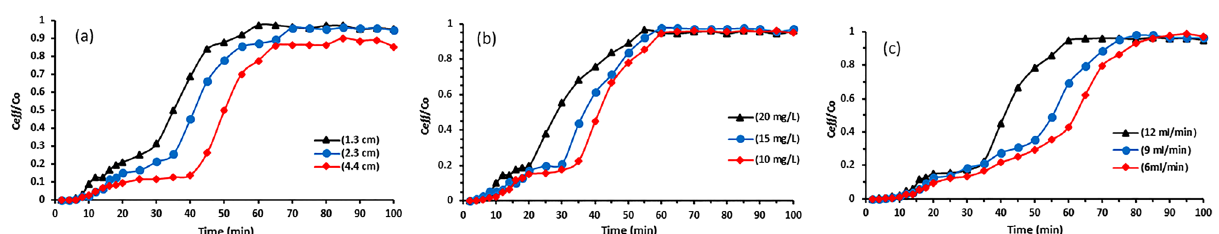
Figure 7. Kinetic adsorption data of pseudofirst-order ( a ) and pseudosecond-order ( b ).